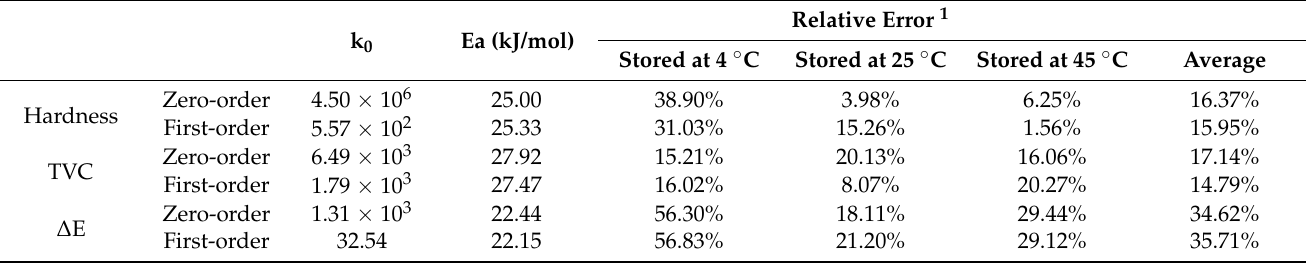
Table 4. Activation energy (Ea) and frequency coefficient (k 0 ) for the zero- and first-order change of quality indices; relative errors between experimental and predicted shelf life for HPP marinated lotus root slices at day